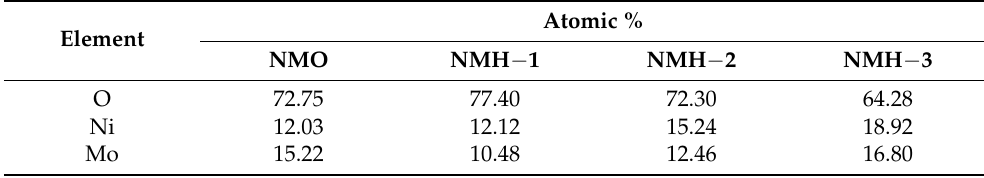
Table 1. Elemental contents of the Mo, Ni, and O of NMO and NMH − 1, 2, 3.